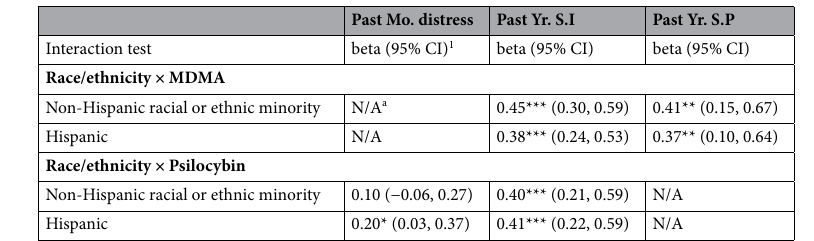
Table 2. Interactions between race and ethnicity and MDMA use and psilocybin use for predicting past month psychological distress, past year suicidal ideation (S.I), and past year suicidal planning (S.P). All aforementioned demographic factors and lifetime use variables are included as covariates. a An N/A value indicates we did not test for an interaction as our prior research (Jones and Nock (2022) 23 ) indicated that there was not an association between MDMA or psilocybin and the specific outcome of interest. 1 *p < 0.05; **p < 0.01; ***p < 0.001; CI = confidence interval.